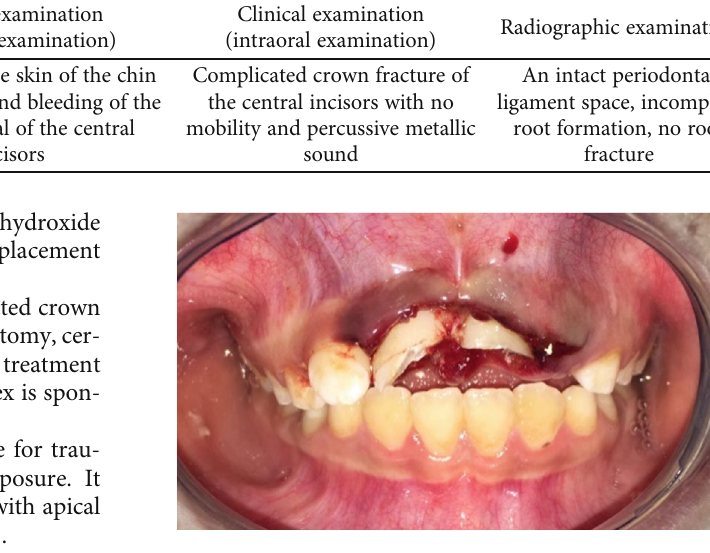
Figure 1: Intraoral examinations.